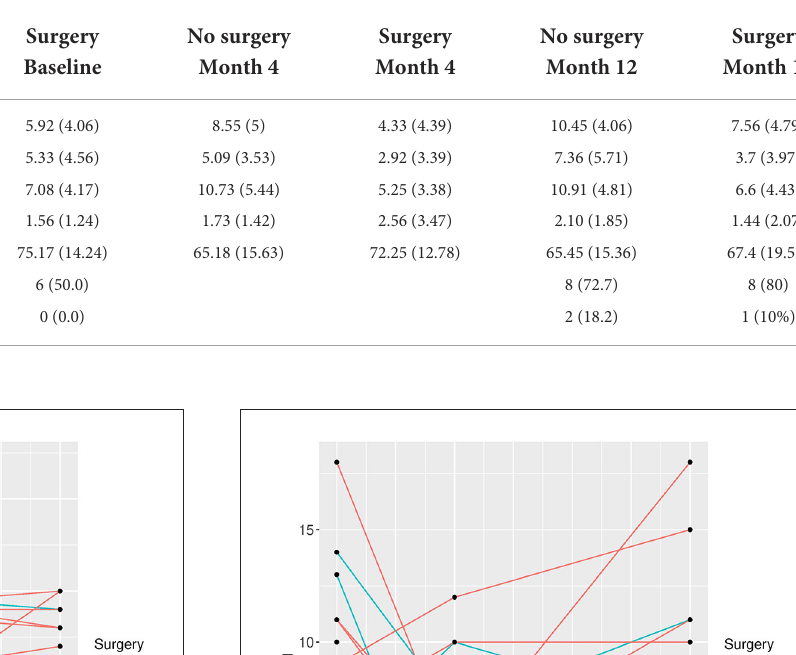
TABLE 2 Clinical variables over time.